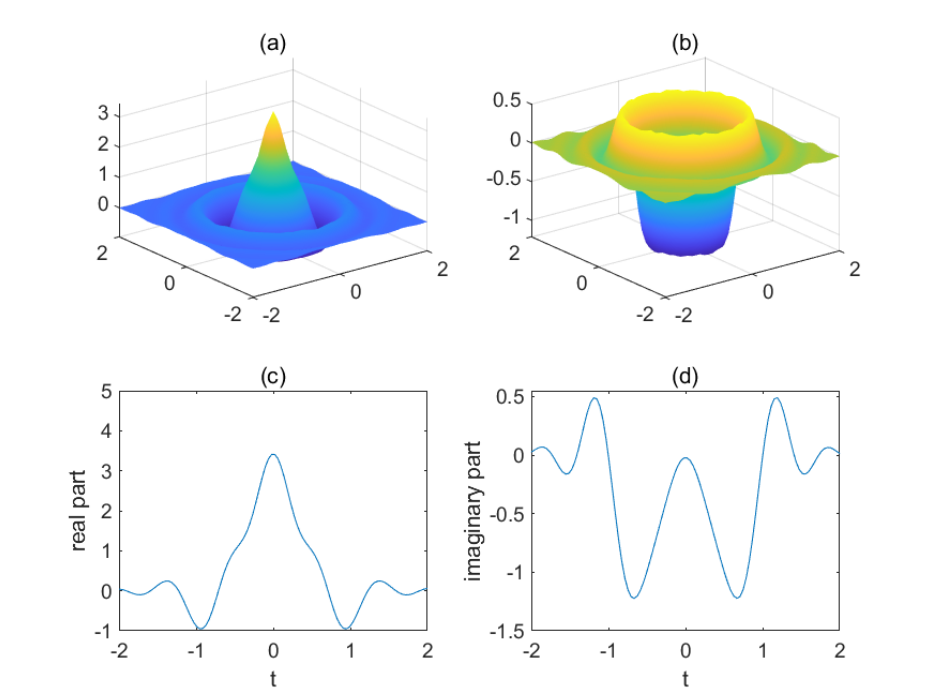
Figure 3. ( a ) Real part graph of g α ( x , y ) with α 1 = α 2 = π